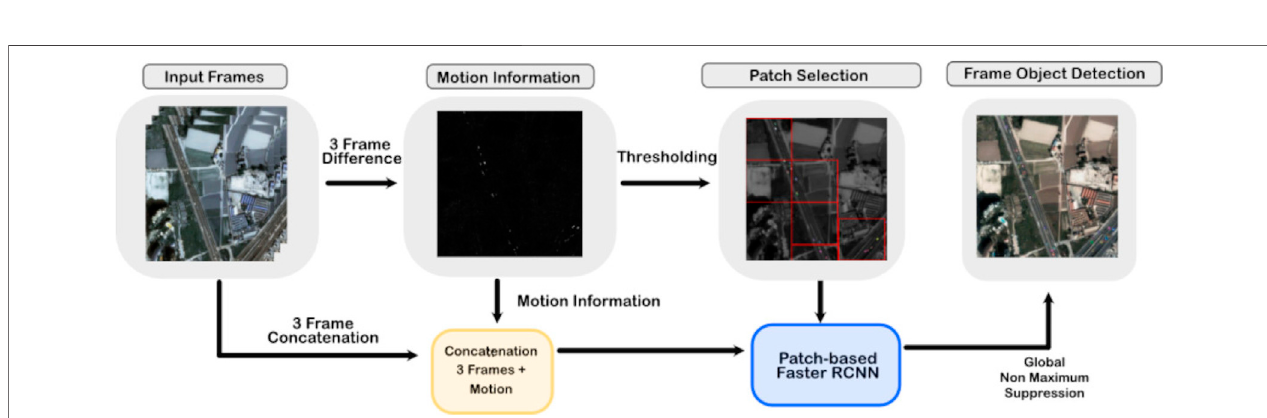
FIGURE 3 | Object detection block